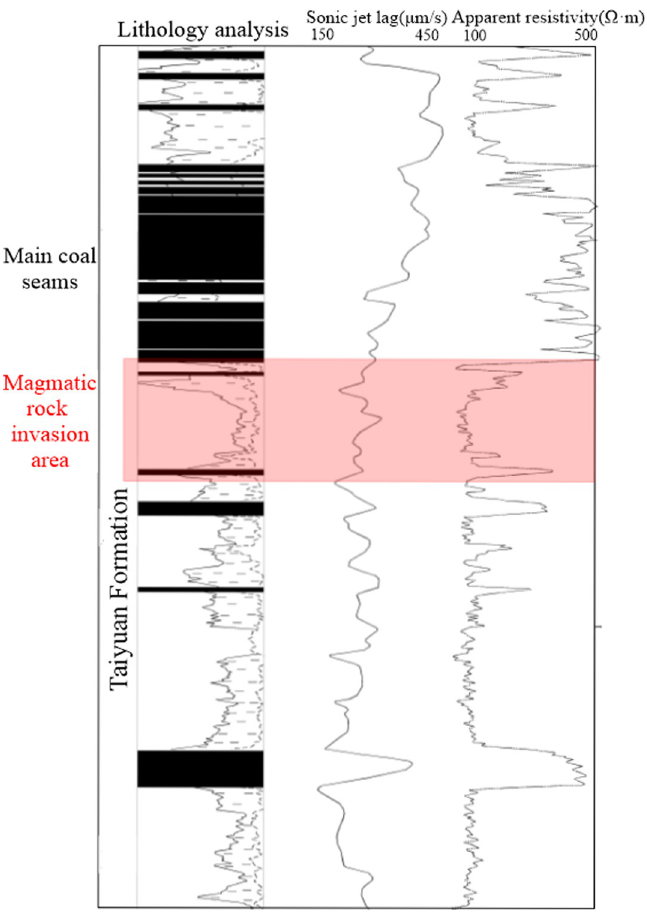
Fig 4. Comprehensive logging curve of the Tongxin Minefield, using lithology curve analysis.